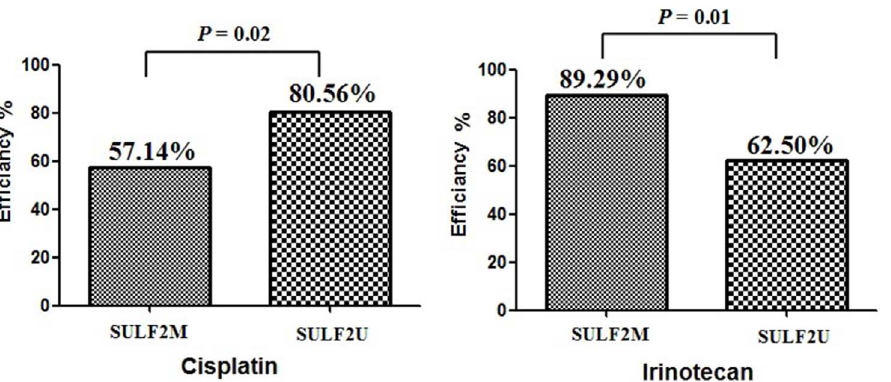
Figure 2. Using the 30% inhibition rate as cut-off, SULF2 methylation was found to have a significant association with cisplatin efficacy ( SULF2M : 57.14%, SULF2U : 80.56%, P =0.02) and irinotecan efficacy ( SULF2M : 89.29%, SULF2U : 62.50%, P =0.01).